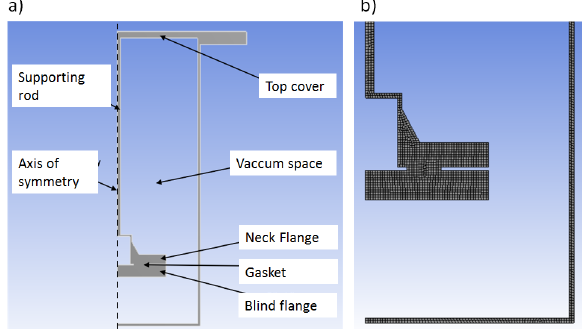
Figure 3: Numerical model a) axisymmetric model of the test rig, b) finite element mesh in the area of the flanged joint and the part of the chamber.